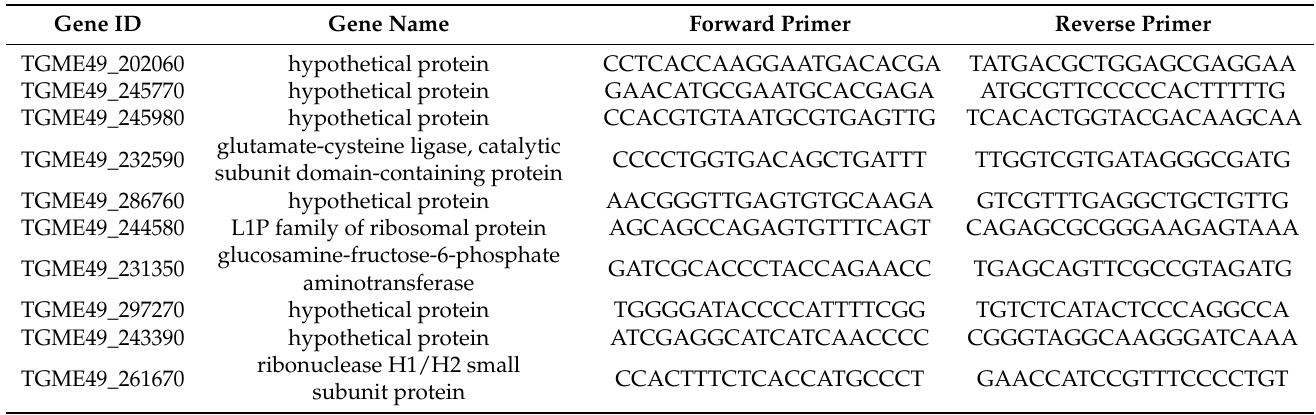
Table 1. qPCR primers used to verify the selected ten differentially expressed genes identified in RNA-seq